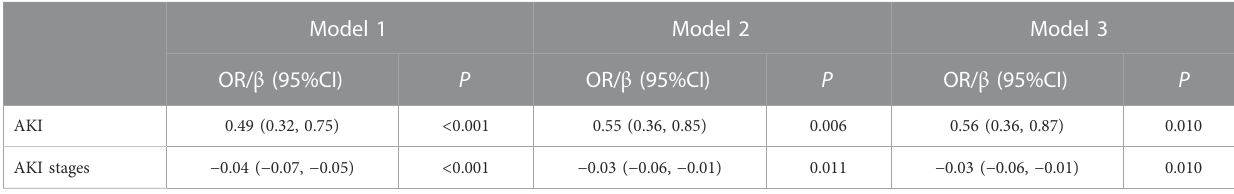
TABLE 3 OR or β value of postoperative AKI or AKI stages associated with perioperative dexmedetomidine administration.